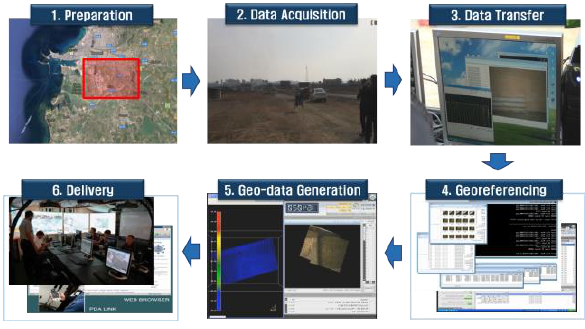
Figure 2. Operation concept of the UAV mapping